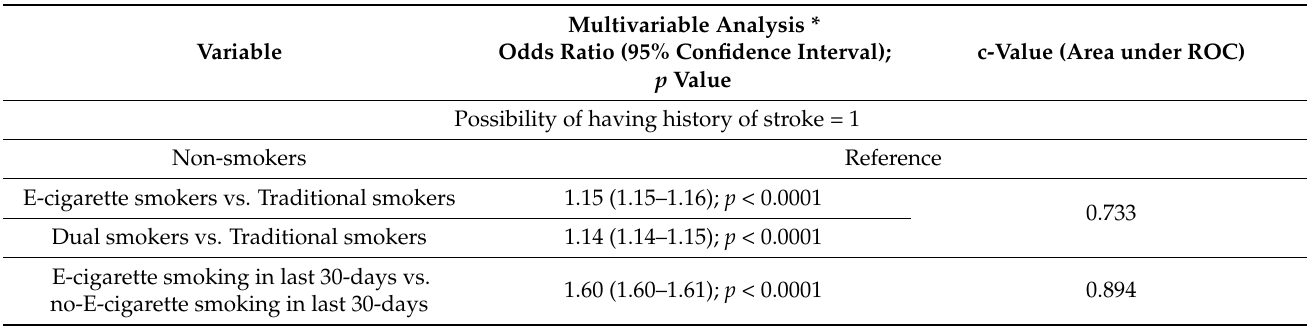
Table 3. Regression analysis showing relationship between various types of tobacco consumption and